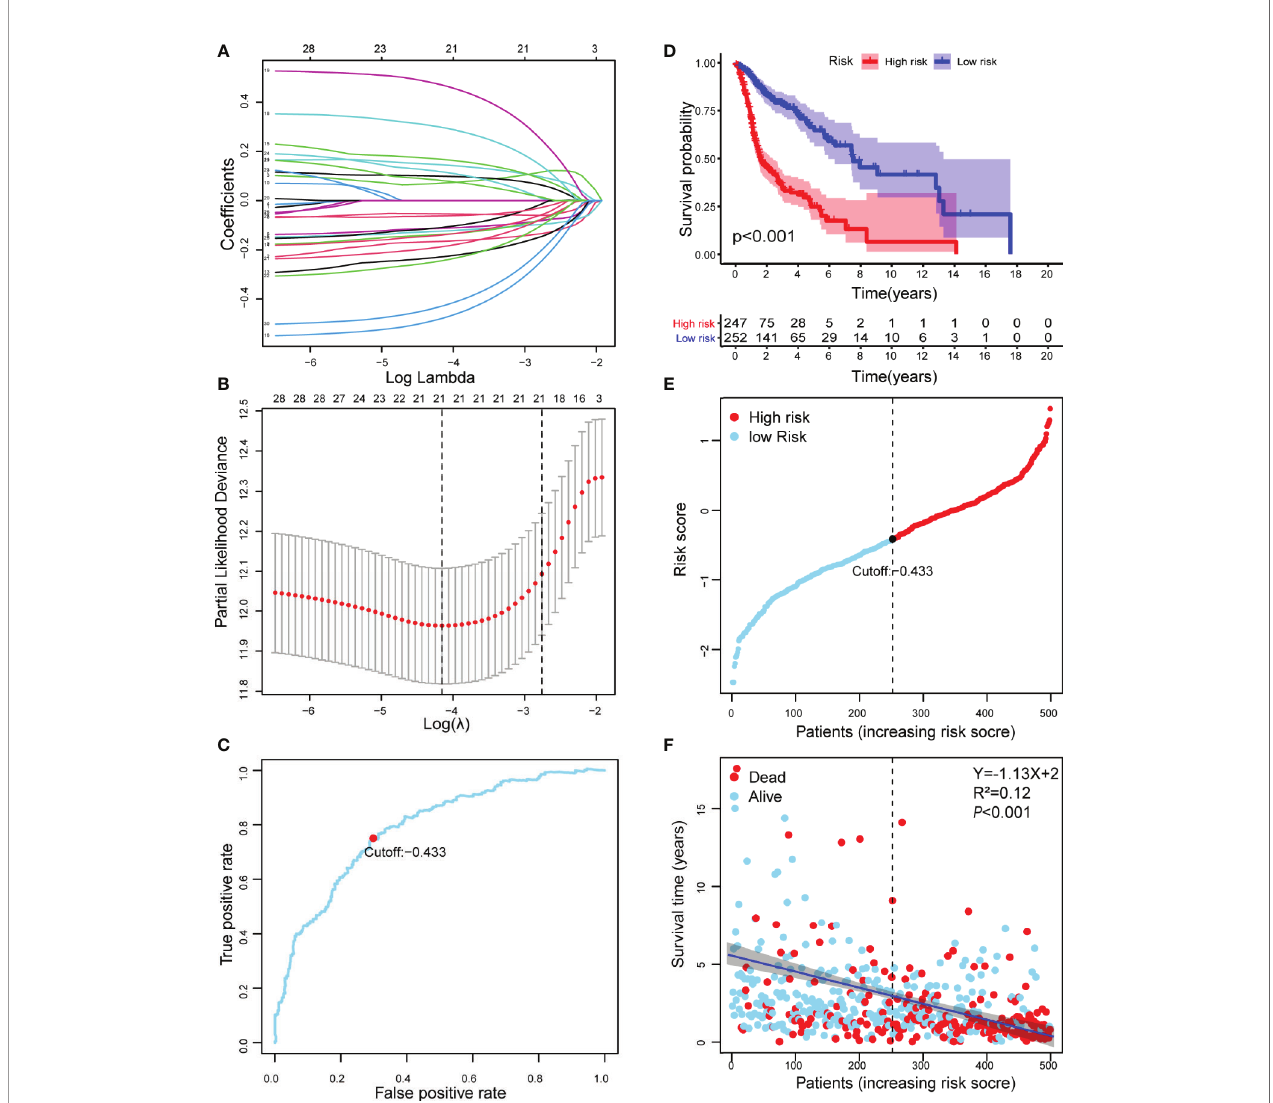
FIGURE 2 | Risk assessment model for prognosis prediction. (A) Validation was performed for tuning parameter selection through the Lasso regression model for OS. (B) Elucidation for LASSO coef fi cient pro fi les of prognostic IRLPs. (C) Time-dependent ROC curve of the IRLPs signature in the TCGA cohort. The optimal cutoff value of the IRLPs signature is -0.433; patients are divided into the high-risk group and the low-risk group according to the cutoff value. (D) Patients were sorted by increasing risk score in the HNSCC set. (E) The Kaplan-Meier survival curve with log-rank test was drawn to demonstrate the relationship between risk model and OS. Compared with the high-risk group, patients in the low-risk group experienced a longer survival time. (F) The survival time and survival status of patients with HNSCC worsened as the risk score increased (Y=-1.13X+2, R 2